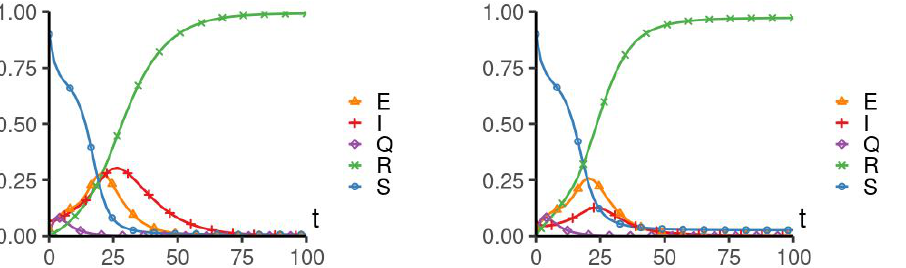
Figure 24. Experiment 4. Sum of the fractions of all levels: uncontrolled ( left ) and controlled cases ( right ) with irresponsible individuals.